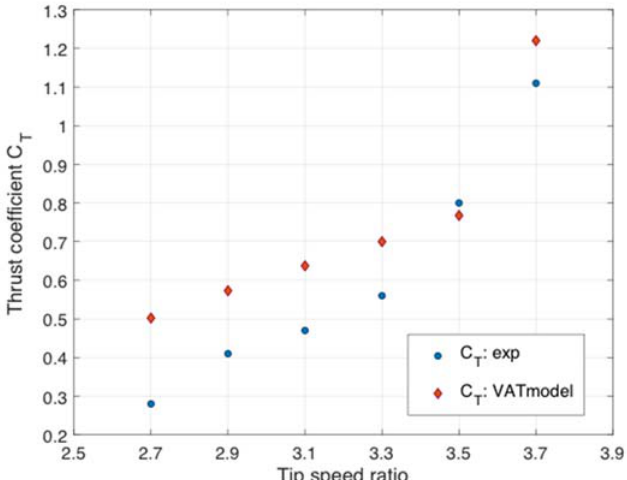
Figure 6. Comparison between predicted and measured [70] mean thrust coe ffi cient C T as a function of tip speed ratio in the range from 2.7 to 3.7, for a wind turbine rotor of a two-bladed H-type vertical-axis wind turbine with incoming flow speed of 4.01 m/s and fixed pitch blade angle of 0 ° .